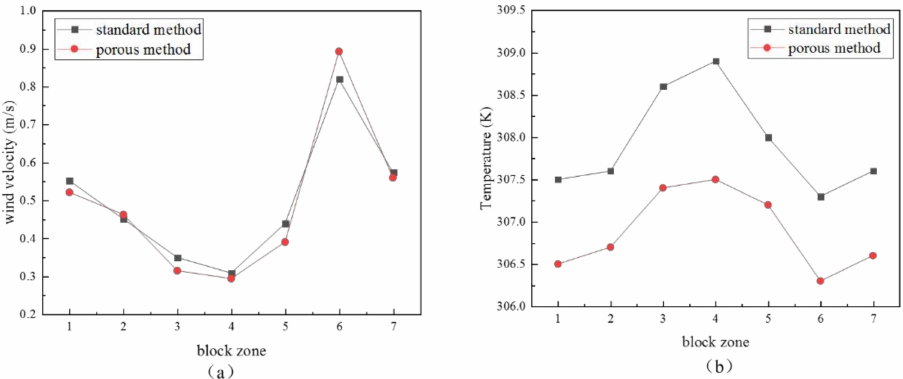
Figure 12. ( a ) Mean wind velocity and ( b ) mean temperature in different block zones.